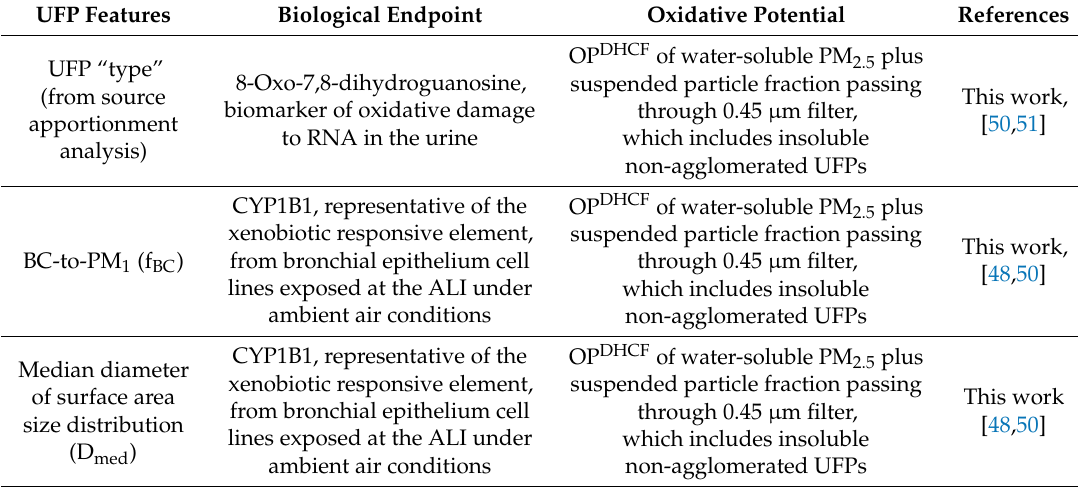
Table 1. UFP features associated with pro-inflammatory and oxidative responses during the CARE